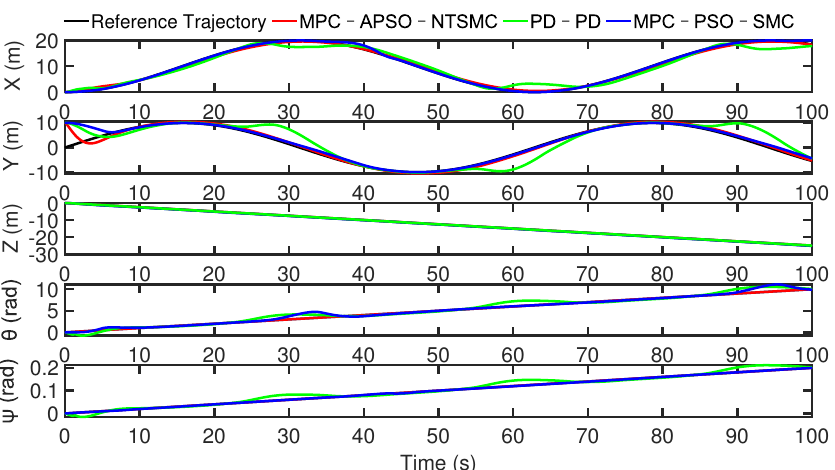
Figure 14. Position tracking performancesfor the tracking task with random disturbance for Case